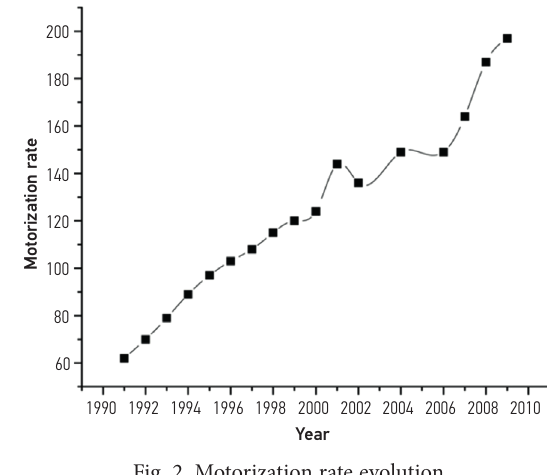
Fig. 2. Motorization rate